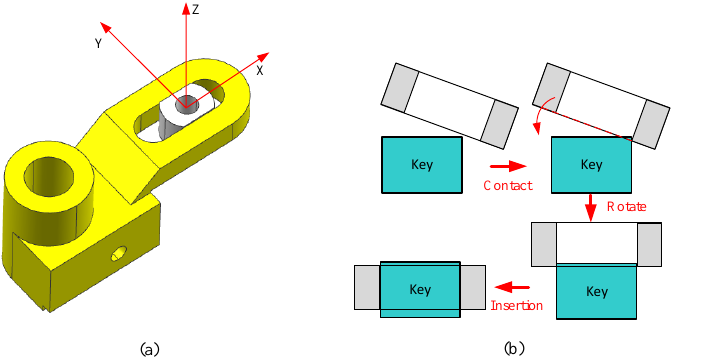
Figure 9. The slot assembly process diagram. ( a ) the key assembled in the slot; ( b ) two-step searching method.